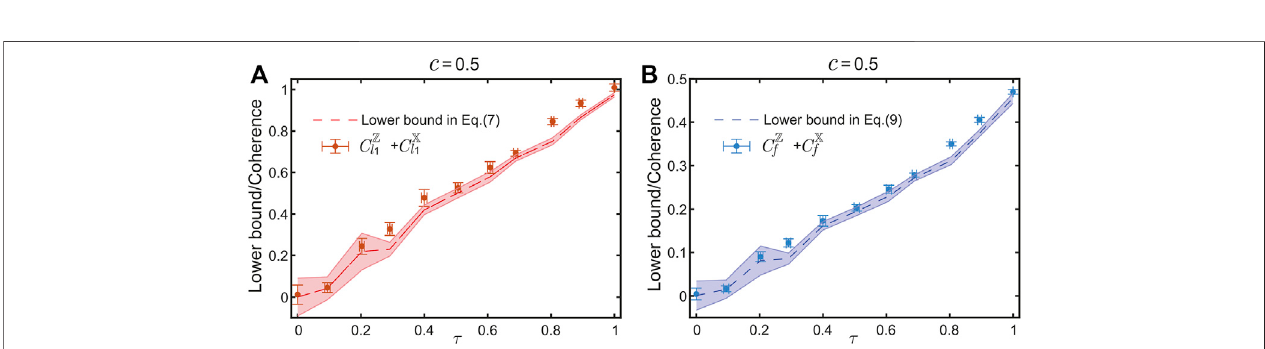
FIGURE 5 | Results of (A) QUR with l 1 norm of coherence and (B) QUR with coherence of formation with c = 0.5.